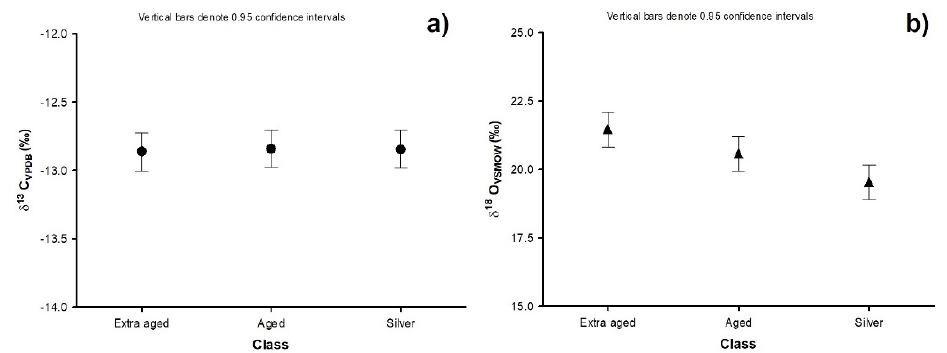
Figure 1. Statistical analysis of the values δ 13 C VPDB ( a ) δ 18 O VSMOW ( b ), different classes of 100% agave tequila (silver, aged, and extra-aged). Table 1. One-way analysis of variance for δ 13 C VPDB and δ 18 O VSMOW in different classes of 100% agave tequila (silver, aged, and extra-aged class). SS: Sum-of-squares, DF: Degrees of freedom, MS: Mean squares, F: F-value = MS intercept /MS error , P: p